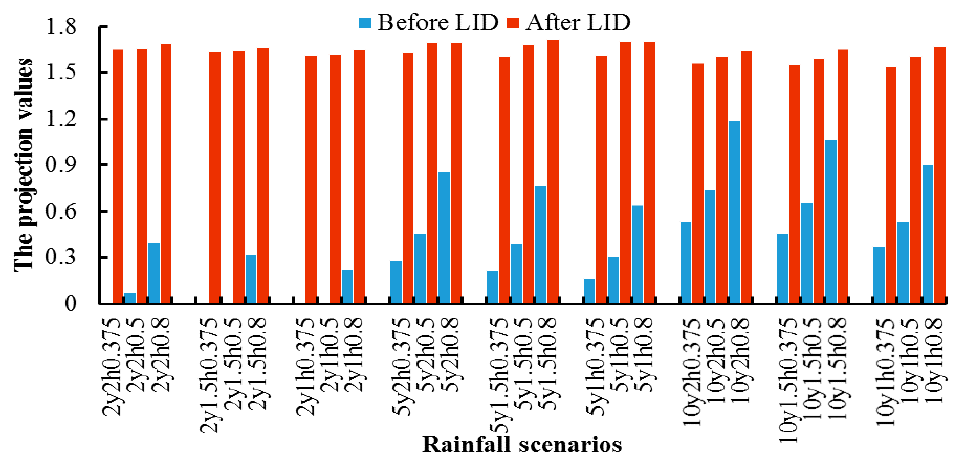
Figure 7. Changes in the projection values of J15 and LID control characteristics under complex scenarios.